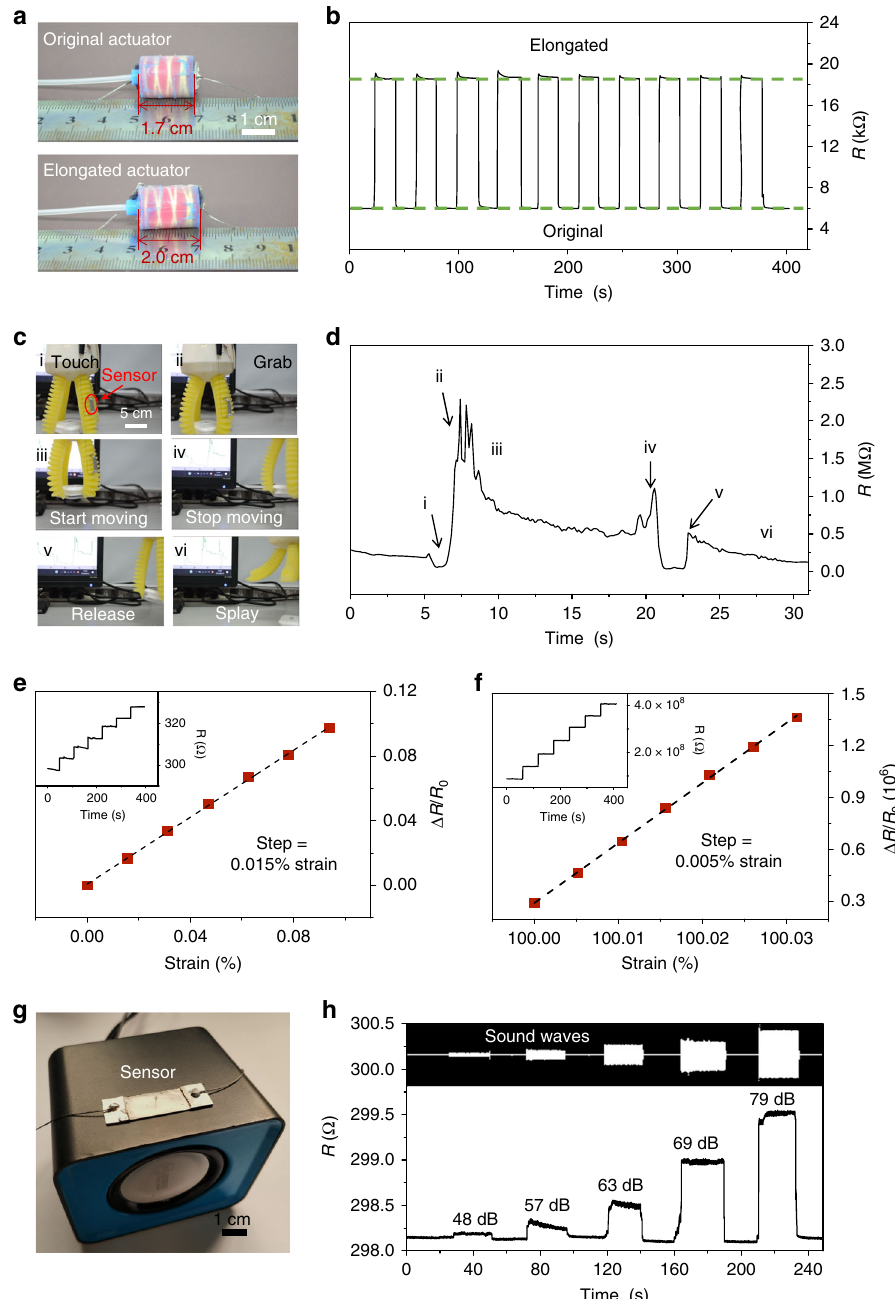
Fig. 4 Ultrastretchable and highly sensitive electronics. a A 1.5-cm-length 1D actuators installed with our metal fi lm-based electronics. b The electrical resistance of the metal fi lm sensor as a function of actuator deformation. c Nanowire-structured Pt fi lms for detection of the soft gripper ’ s locomotion. d Variation of the resistance of the metal fi lm sensor in the process of grabbing-holding-releasing objects by the soft gripper (see Supplementary Movie 3 and 4). e , f Δ R / R 0 of cracked Pt fi lm on nanowire clusters versus strain within the range of ( e ) 0 – 0.1% or ( f ) 100 – 100.03%. Insets show the corresponding resistance as a function of strain. g A nanowire-structured Pt fi lm-based sensor mounted on a loudspeaker. h In fl uence of sound intensity on the resistance of the metal fi lm sensor (See Supplementary Movie 5). The length of the nanowire is 4 µ